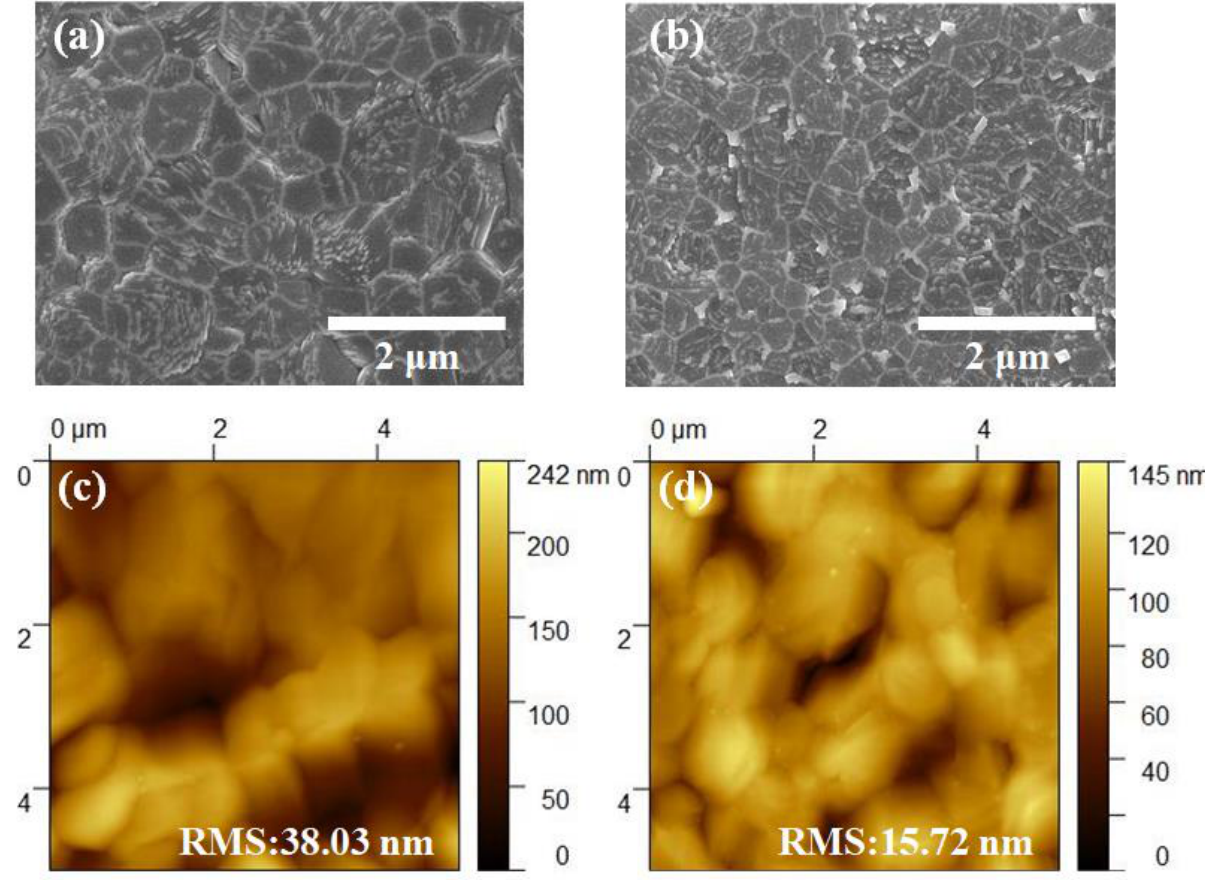
Figure 2. SEM images of ( a ) untreated 2D/3D perovskite films and ( b ) MT/IPA-treated 2D/3D perovskite films; AFM images of ( c ) untreated 2D/3D perovskite films and ( d ) MT/IPA-treated 2D/3D perovskite films.